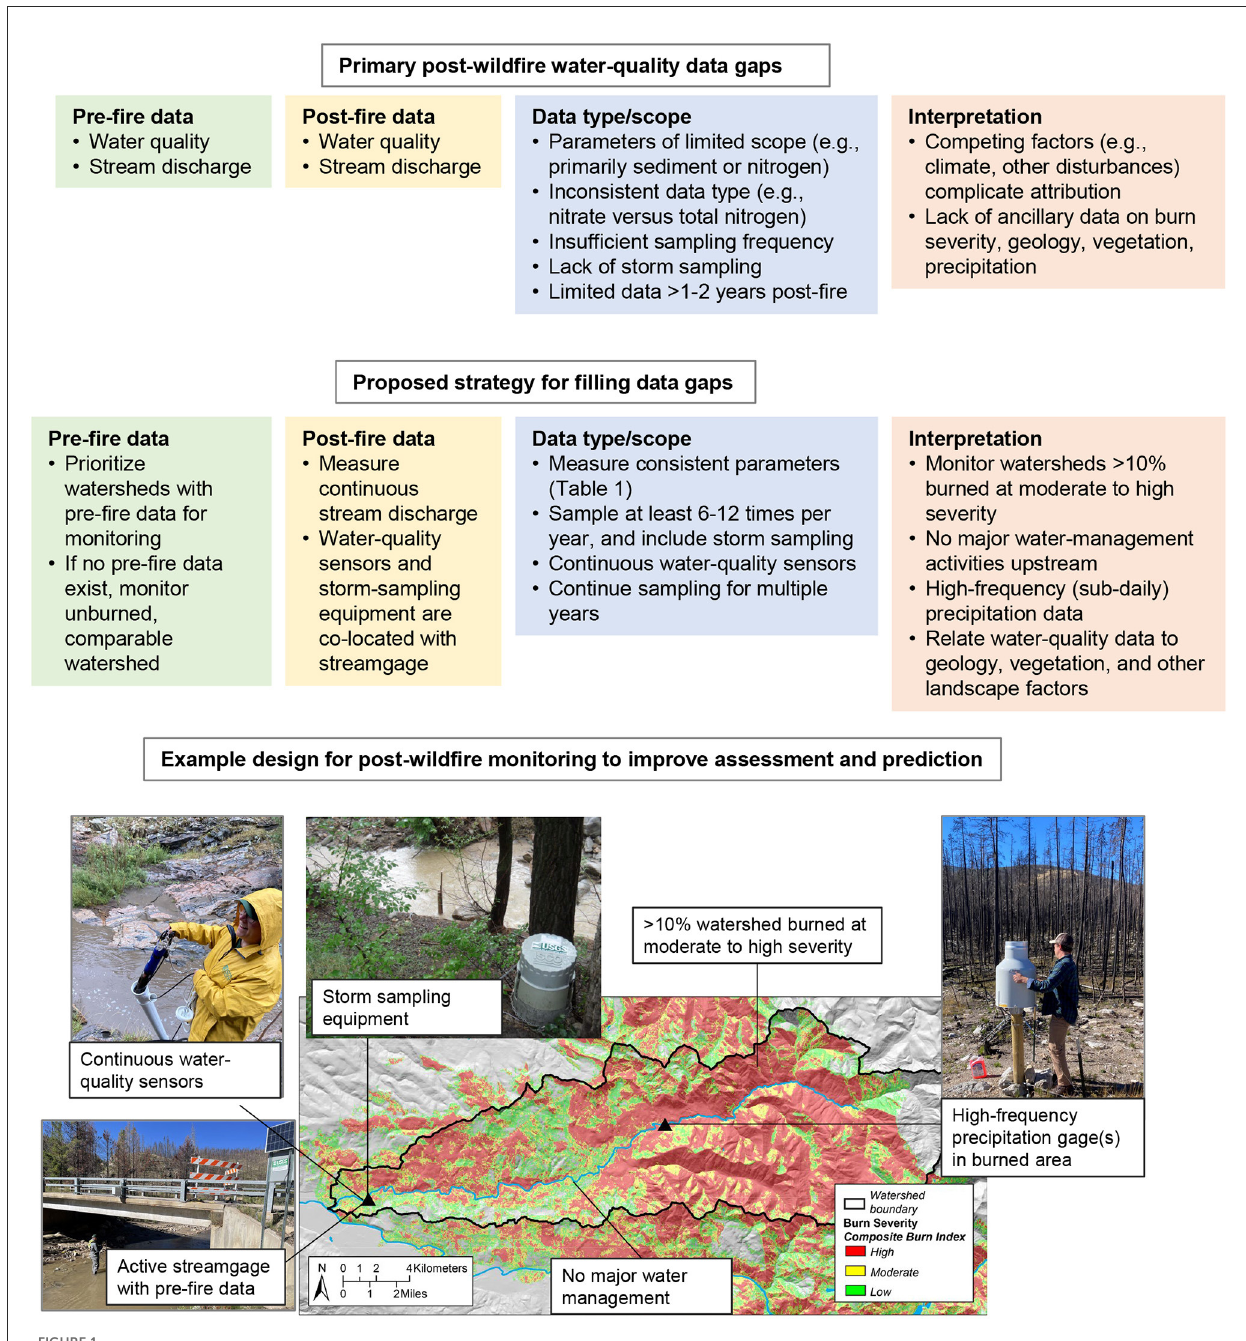
FIGURE1 Post-wildfire water-quality gaps and proposed gap-filling strategy. [Composite burn index (Key and Benson, 2006) rates burn severity for substrates (litter, duff, fuel, and soil) and vegetation on a continuous scale from 0 (unburned) to 3 (high burn severity). Map prepared by Max Schwid; photographs by Sheila Murphy and Mike